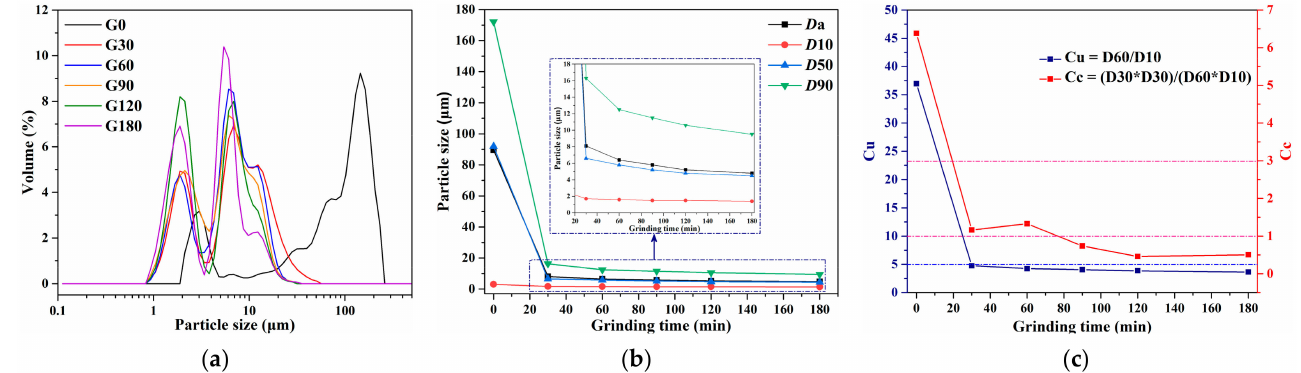
Figure 2. Particle size distribution ( a ), characteristic particle parameters ( b ), Cu and Cc ( c ) of G0 and Gx. D10, D30, D50, D60, and D90 represent the diameter when the cumulative distribution reaches 10, 30, 50, 60, and 90%, respectively.